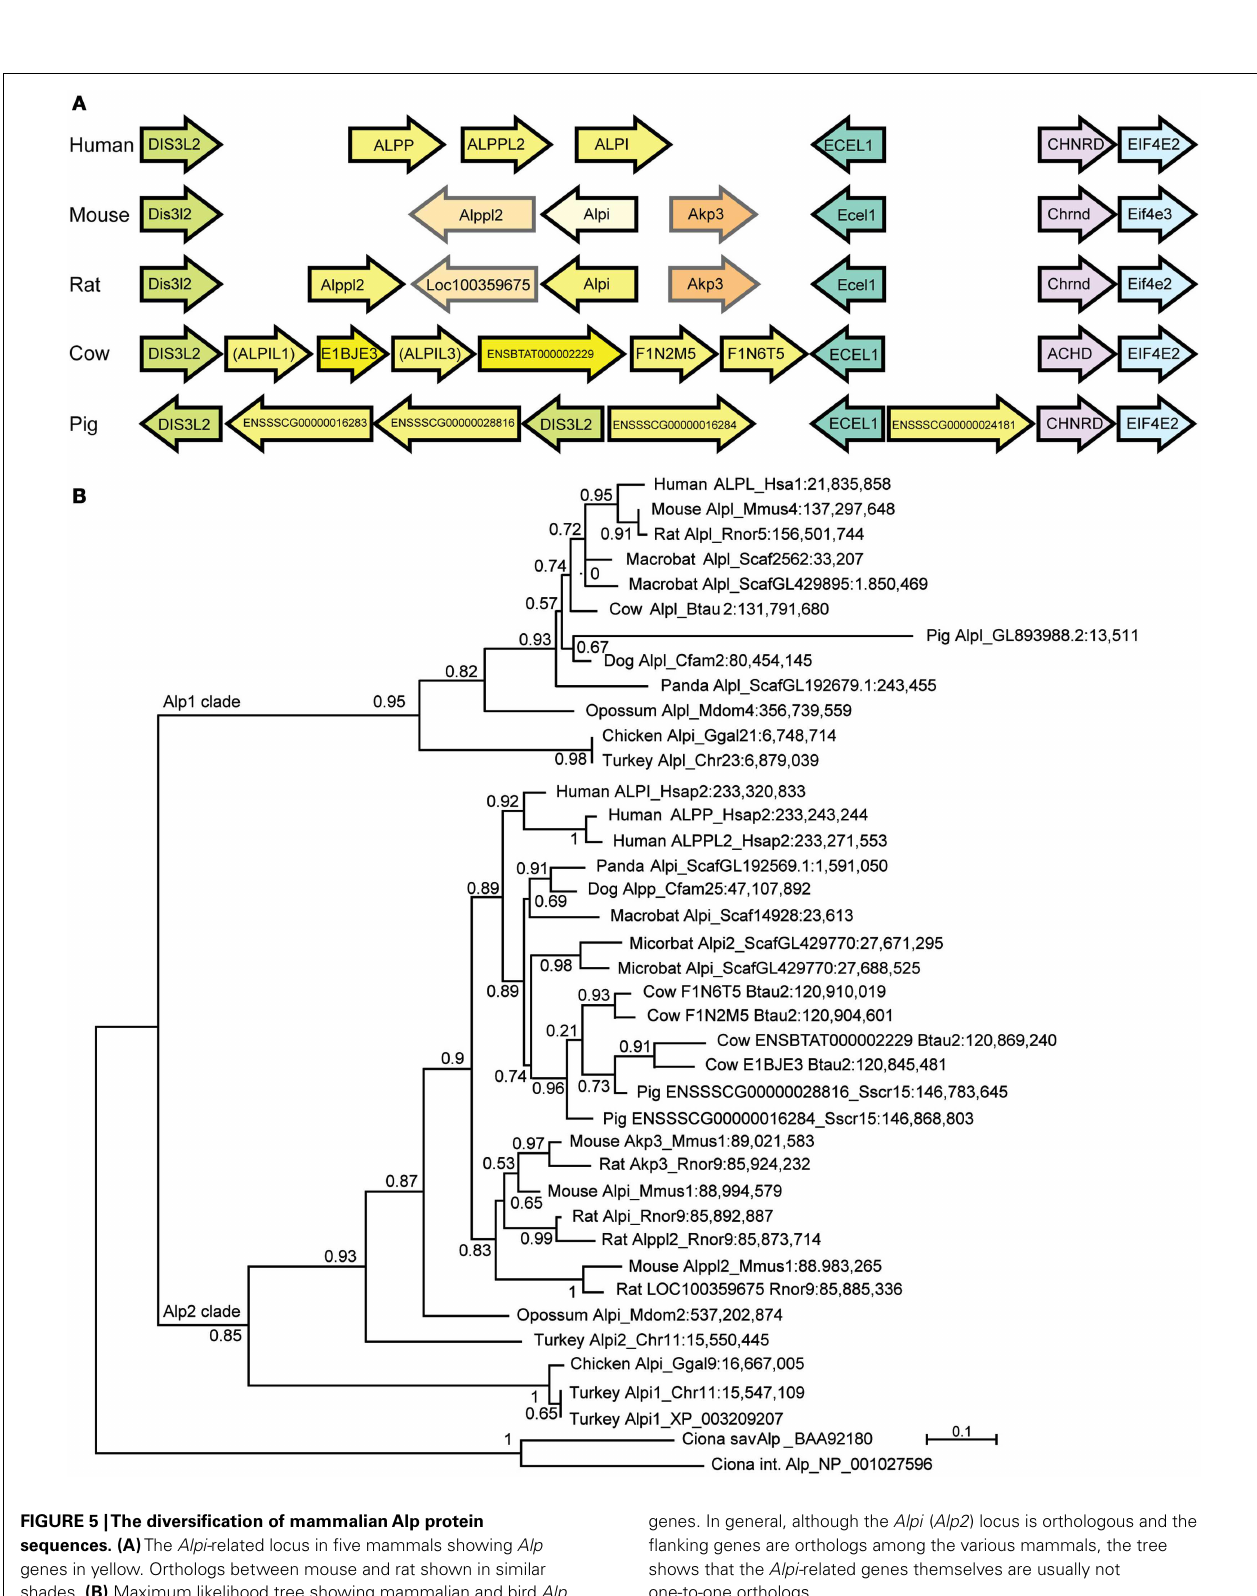
FIGURE 5 |The diversification of mammalianAlp protein sequences. (A) The Alpi- related locus in five mammals showing Alp genes in yellow. Orthologs between mouse and rat shown in similar shades. (B) Maximum likelihood tree showing mammalian and bird Alp